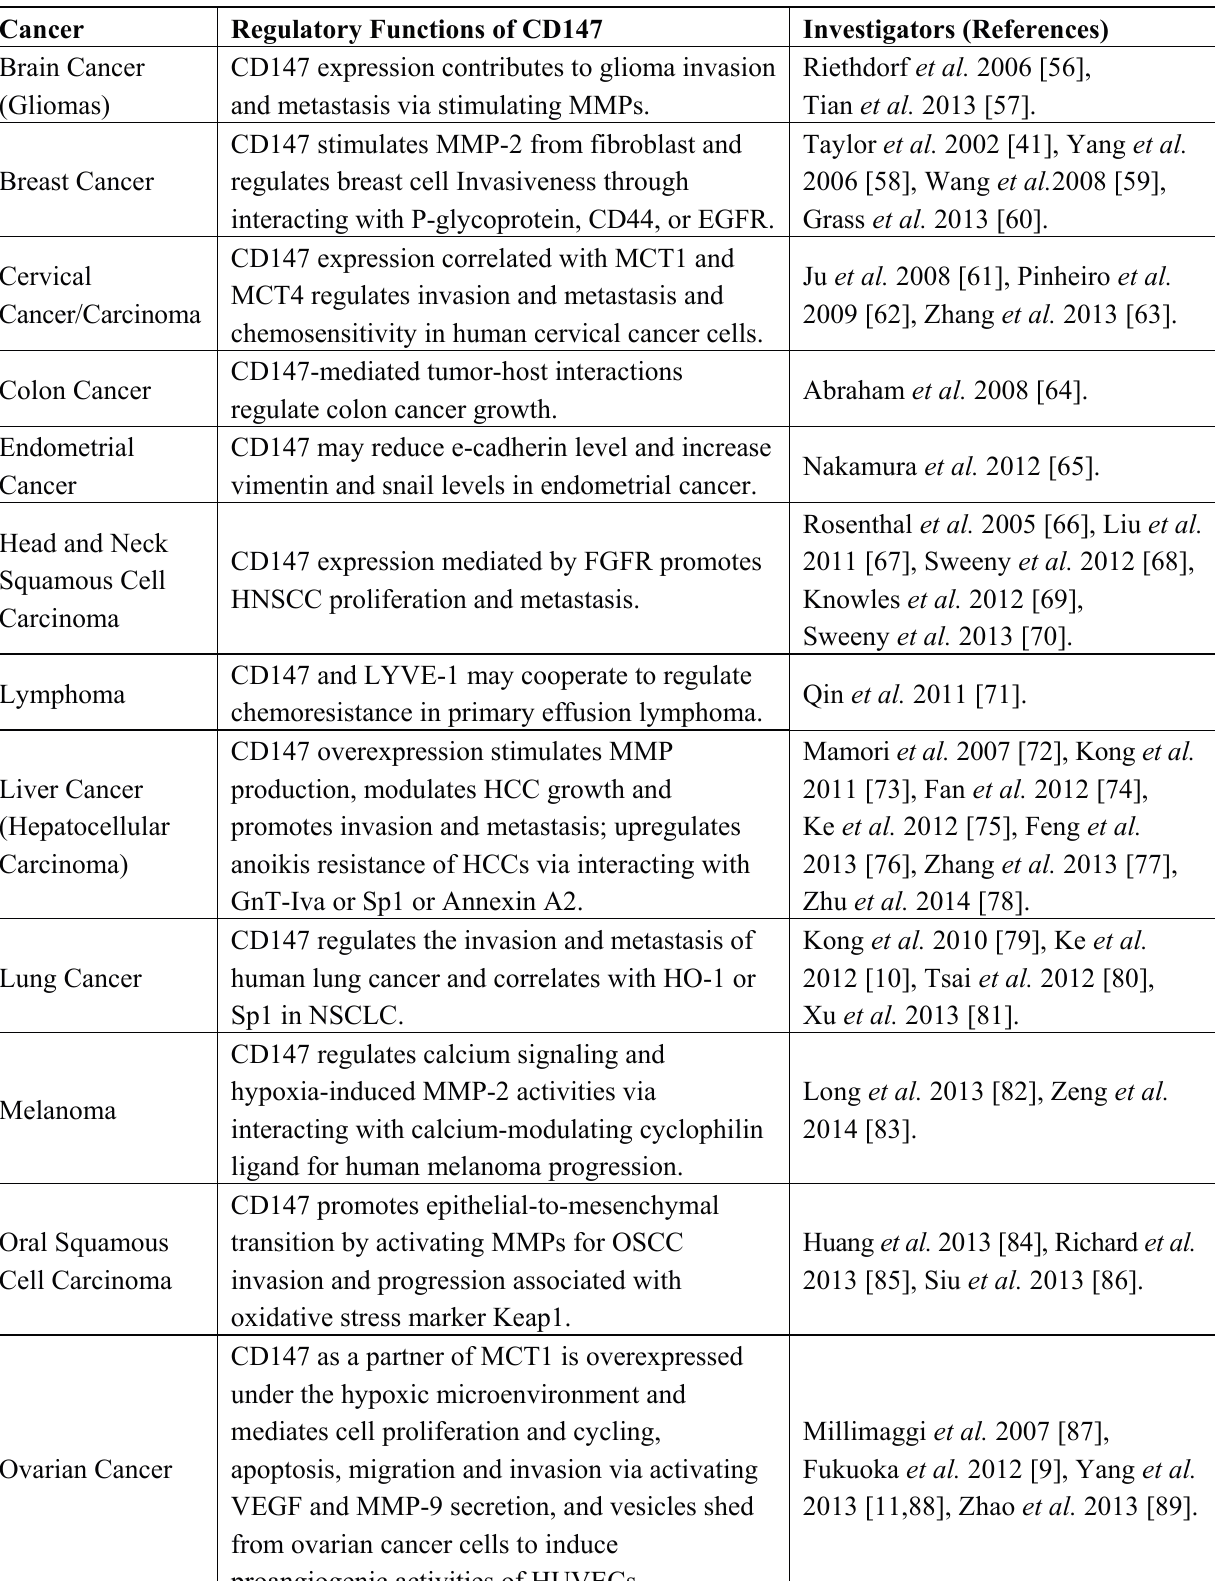
Table 1. Dysregulation of CD147 has been associated with nearly every type of